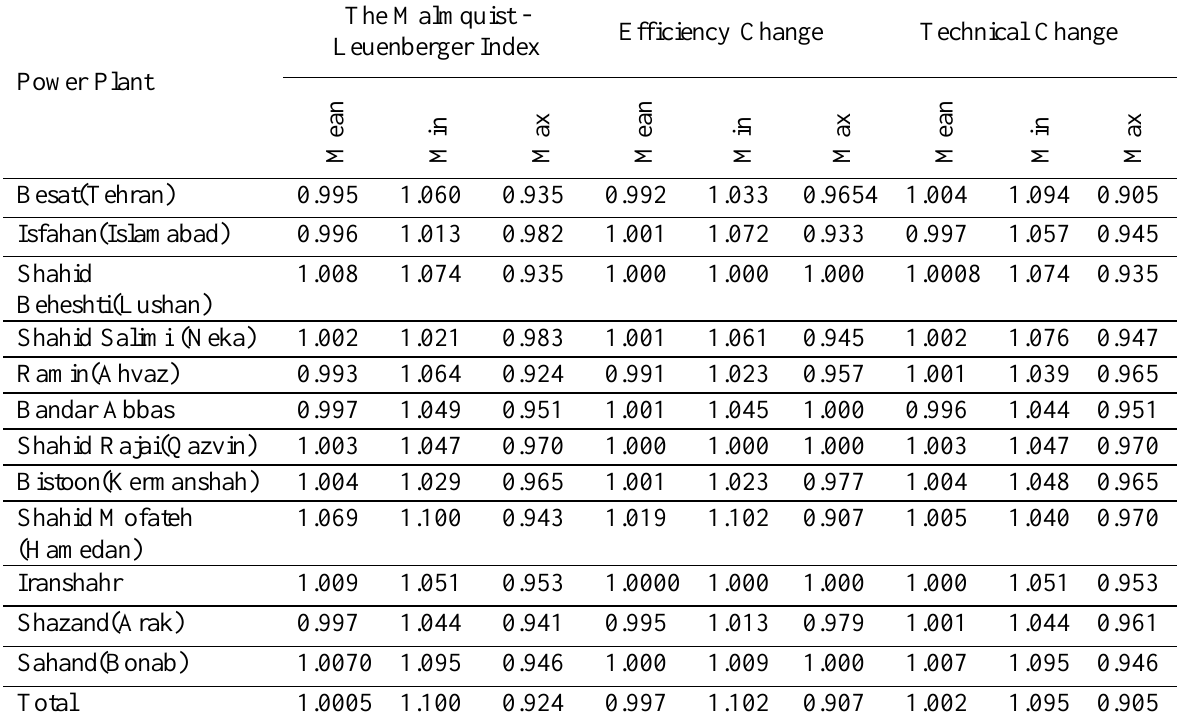
Table 2. The Malmquist -Leuenberger Index in Iranian steam power